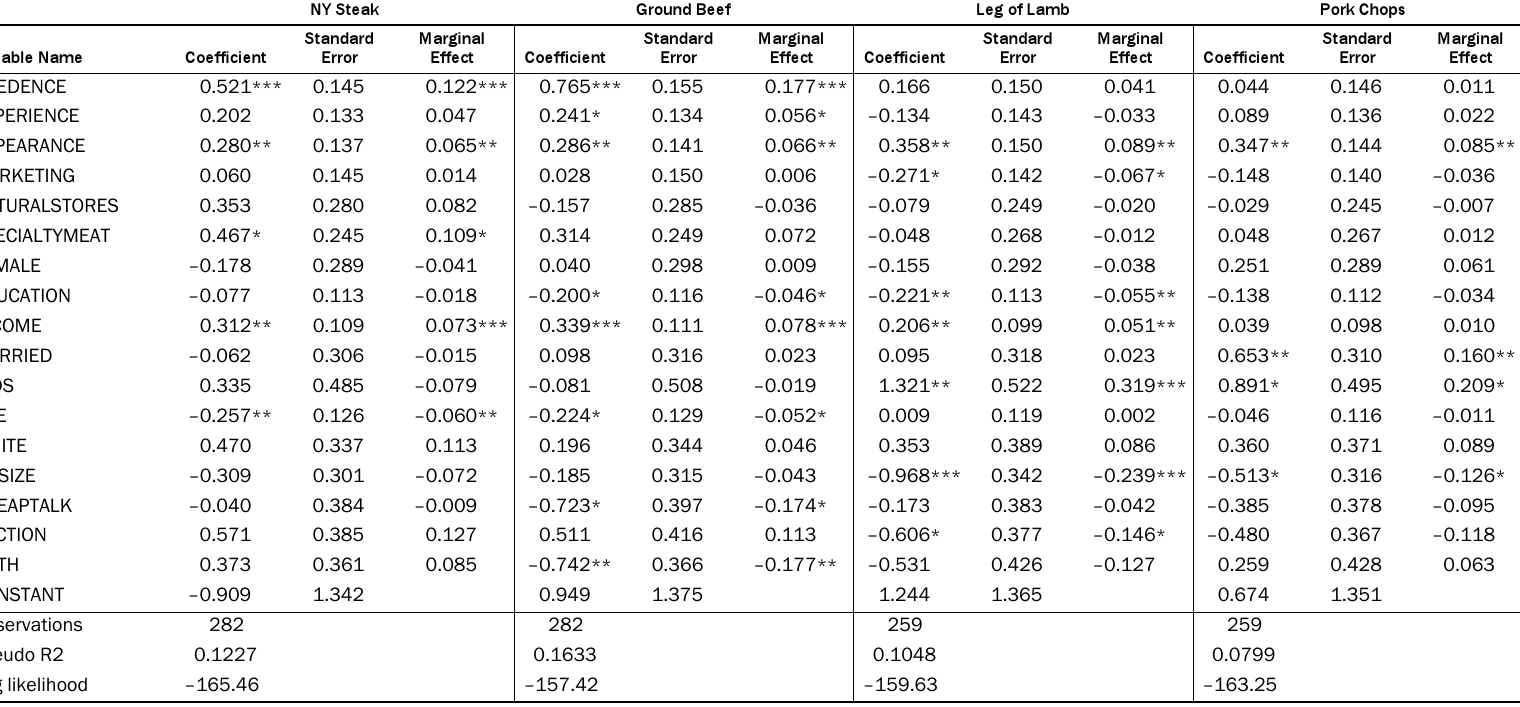
Table A1. Consumer Willingness to Purchase Model Results